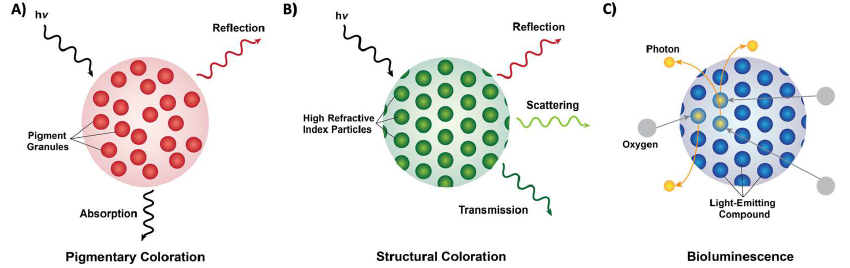
Figure 1. Forms of coloration in nature. ( A ) A schematic of pigmentary coloration in nature, where the incident light (h v ) is absorbed or reflected by pigment granules (red circles), with no apparent long-range order. ( B ) A schematic of structural coloration in nature, where the incident light (h v ) is reflected, scattered, or transmitted by high refractive index particles (green circles) showing long- range order. ( C ) A schematic of bioluminescence in nature, where oxygen (grey circles) reacts with a light-emitting compound such as luciferin (blue circles) and releases photons (yellow circles).